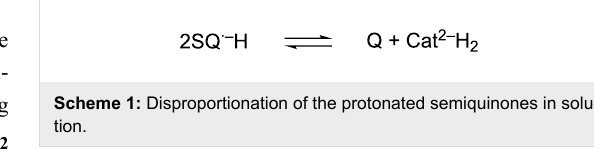
Scheme 1: Disproportionation of the protonated semiquinones in solu- tion.